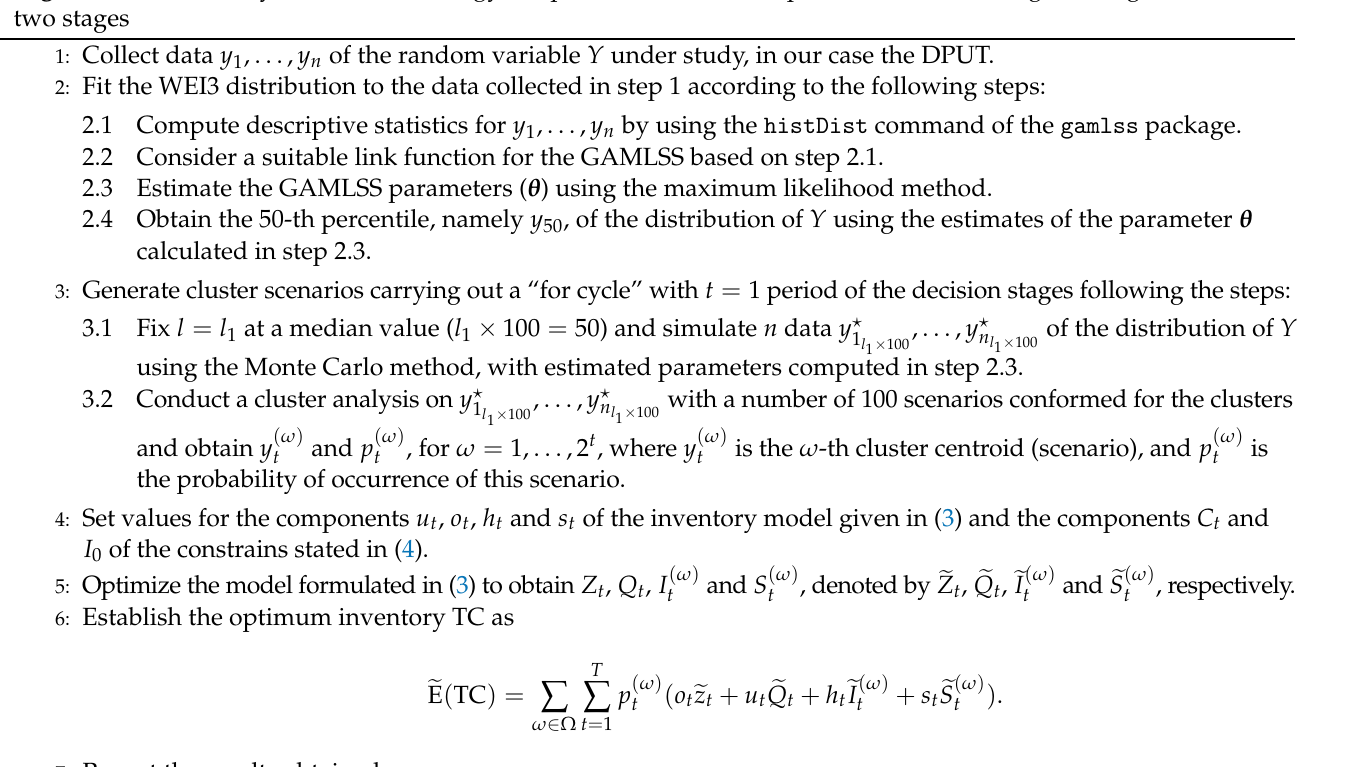
Algorithm 2: Summary of the methodology to optimize TC over one period of decision stages, using SP in two